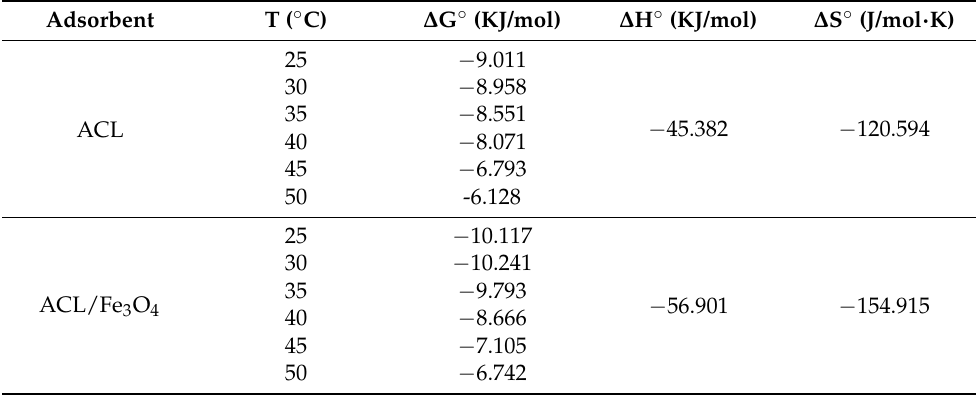
Figure 8. ( a ) The effect of temperature on the adsorption efficiency (pH = 9, contact time for ACL and ACL/Fe 3 O 4 magnetic nanocomposite 80 and 60 min, respectively, adsorbent dose for ACL and ACL/Fe 3 O 4 magnetic nanocomposite 2 and 1.25 g/L, respectively, initial dye concentration of 10 mg/L); ( b ) the linear relation of van’t Hoff equation to determine thermodynamic parameters. Data are mean of triplicate measurements. ( a ) error bars indicate SD values. Table 3. Thermodynamic parameters for the CV dye adsorption